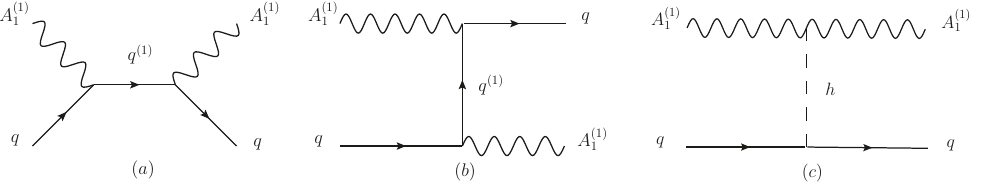
Figure 8 . Tree level diagrams for the elastic scattering of A (1) scattering occurs through the level 1 KK quark and in (cid:12)gure (c) through the SM Higgs.